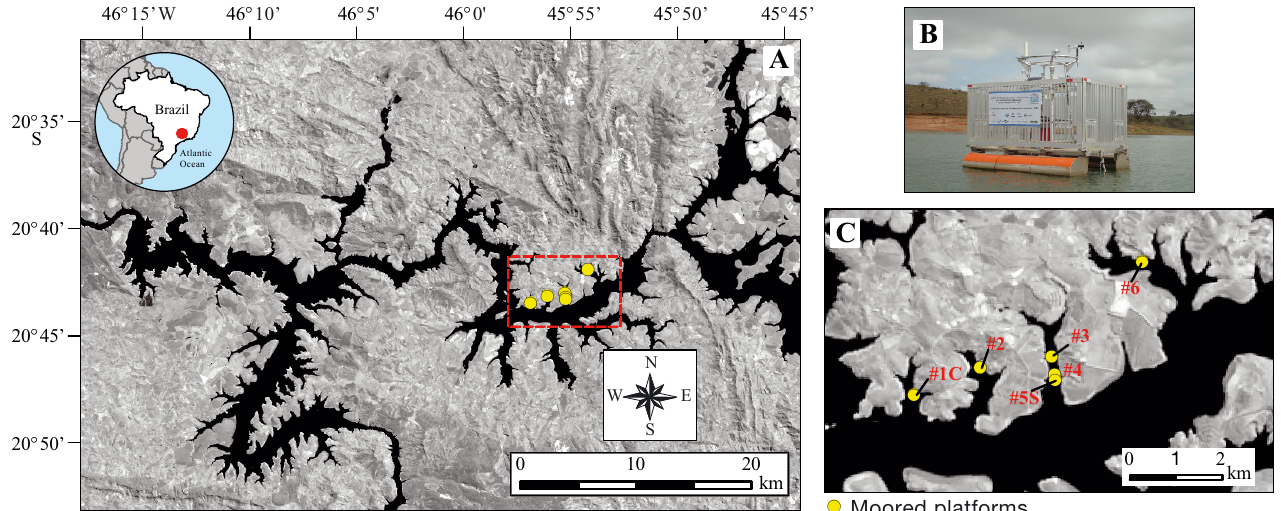
Fig. 1. (A) Furnas Hydroelectric Reservoir (red dot in inset) in Brazil and location of monitoring platforms (yellow dots). (B) In- tegrated System for Environmental Monitoring (SIMA) at platform #5S. (C) Zoom-in of red dashed box in (A) with the 6 moored platforms shown. Images in (A,C) from Landsat 8 OLI, near-infrared band, August 3,